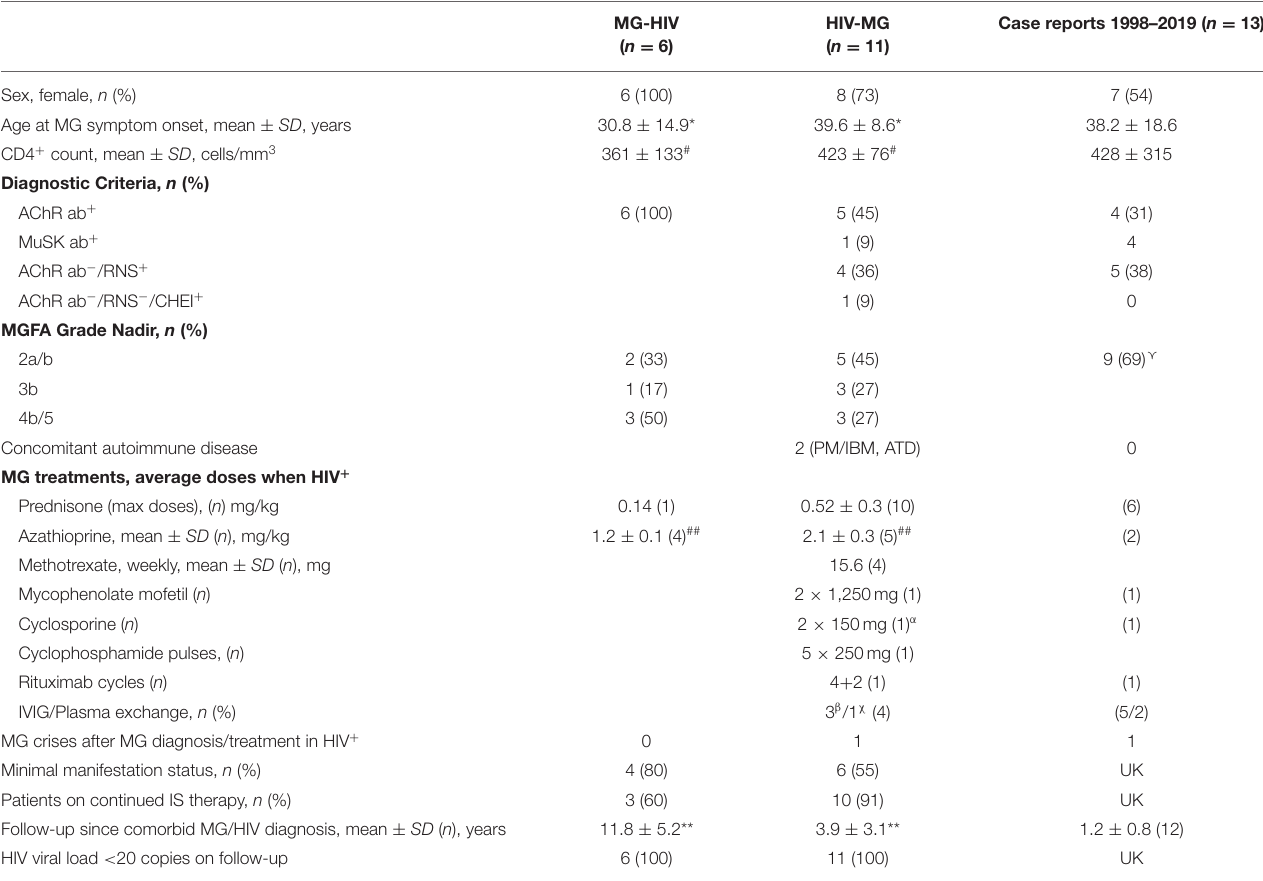
TABLE 1 | Clinical characteristics of patients with concomitant MG and HIV